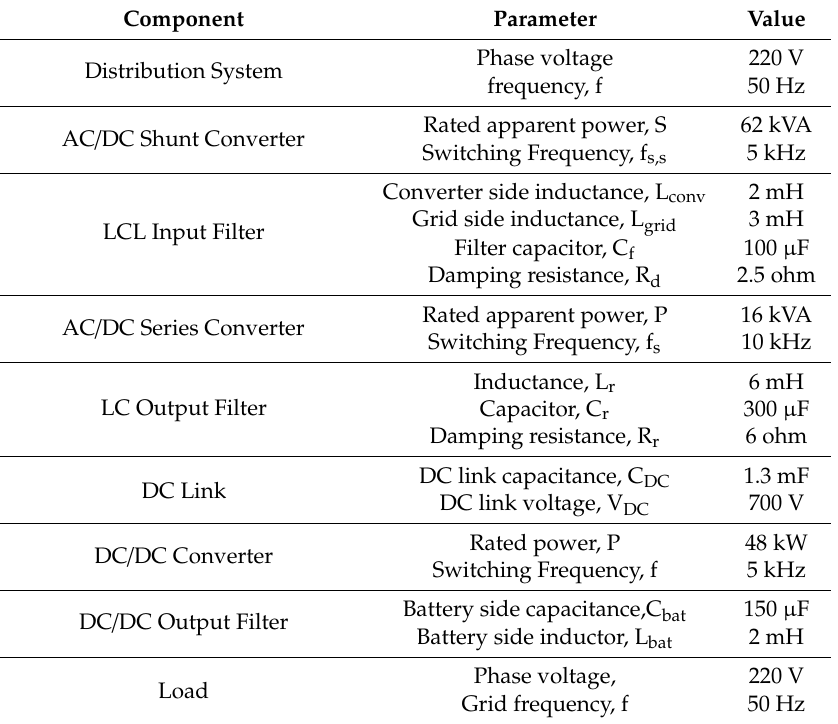
Figure 9. Simulated model schematic. Table 1. Simulation system parameters.